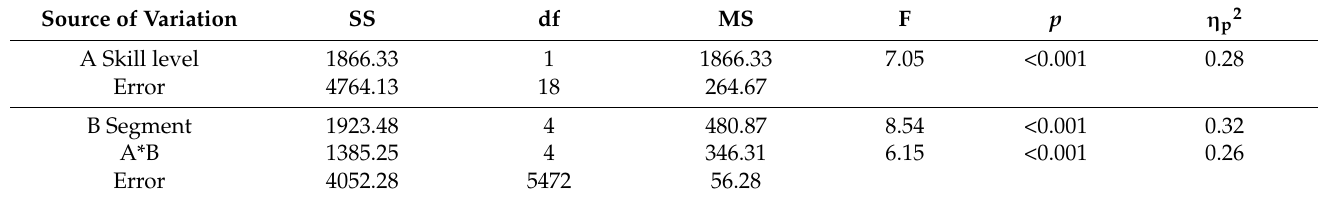
Table 2. Two-way ANOVA evaluations of group and segment effects.